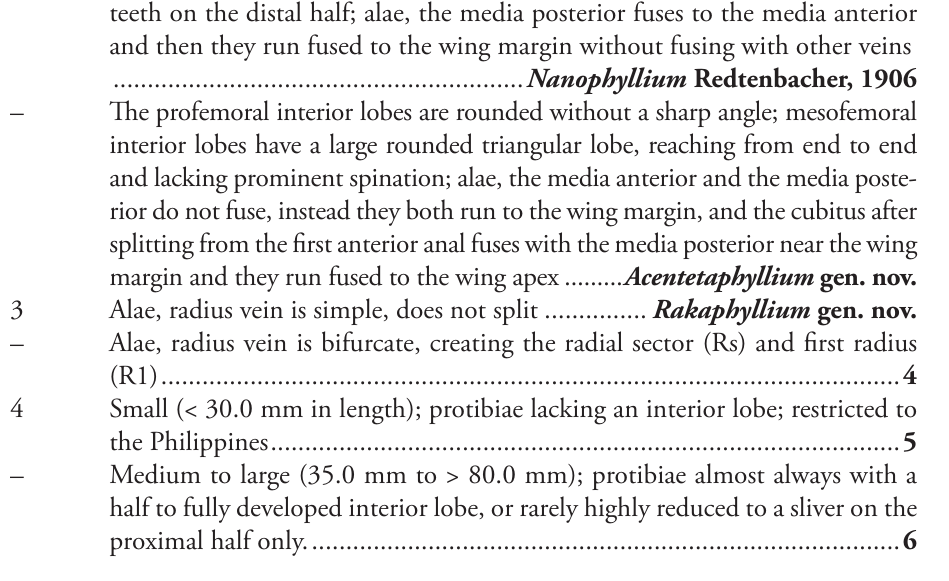
Coxae ventrally are sky blue in color; prescutum anterior rim strongly pro- truding and distinctly angled posteriorly; tegmina radial vein (R) diverges steadily from media (M) for the full length, therefore the split of the radial sector (Rs) is not a significant bend ........................... Chitoniscus Stål, 1875 – Coxae ventral color is the same color as the legs and thorax; prescutum an- terior rim and spine not strongly protruding posteriorly, only slightly raised and vertical; tegmina radial vein (R) runs parallel with media (M) until the split of the radial sector (Rs), at which point the radial sector (Rs) bends away distinctly ......................................... Trolicaphyllium Cumming et al. 2021 12 Third antennomere with the proximal end broad and often slightly recurved, making the segment a similar width throughout, or broader on the proximal end; fourth antennomere short and disk-like at least 3× wider than long and notably shorter than any of the following three segments, or rarely a similar length to the following segment, but still at least 2× as wide as long .............. ....................................................... Cryptophyllium Cumming et al., 2021 – Third antennomere narrowest on the proximal end, broadening to the distal end; fourth antennomere typically as long as wide and of a similar length to each of the following three segments length, not notably shorter .................. ................................................................................. Phyllium Illiger, 1798 Key to males 1 Posteriormedial tubercle of the head capsule split into two lobes ................. 2 – Posteriormedial tubercle of the head capsule singular, not split into two lobes ........................................................................................................... 3 2 The profemoral interior lobes are angular; mesofemoral interior lobes are heavily weighted towards the distal end and are marked by distinct serrate teeth on the distal half; alae, the media posterior fuses to the media anterior and then they run fused to the wing margin without fusing with other veins ............................................................ Nanophyllium Redtenbacher, 1906 – The profemoral interior lobes are rounded without a sharp angle; mesofemoral interior lobes have a large rounded triangular lobe, reaching from end to end and lacking prominent spination; alae, the media anterior and the media poste- rior do not fuse, instead they both run to the wing margin, and the cubitus after splitting from the first anterior anal fuses with the media posterior near the wing margin and they run fused to the wing apex ......... Acentetaphyllium gen. nov. 3 Alae, radius vein is simple, does not split ............... Rakaphyllium gen. nov. – Alae, radius vein is bifurcate, creating the radial sector (Rs) and first radius (R1) ............................................................................................................ 4 4 Small (< 30.0 mm in length); protibiae lacking an interior lobe; restricted to the Philippines ............................................................................................ 5 – Medium to large (35.0 mm to > 80.0 mm); protibiae almost always with a half to fully developed interior lobe, or rarely highly reduced to a sliver on